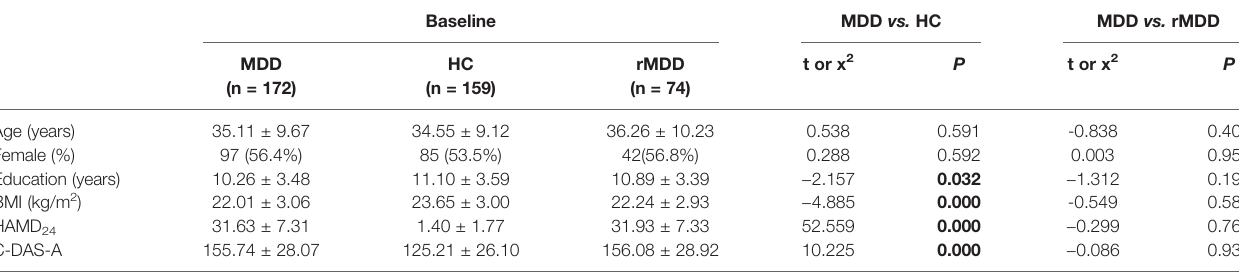
TABLE 1 | Demographic and clinical information by groups.